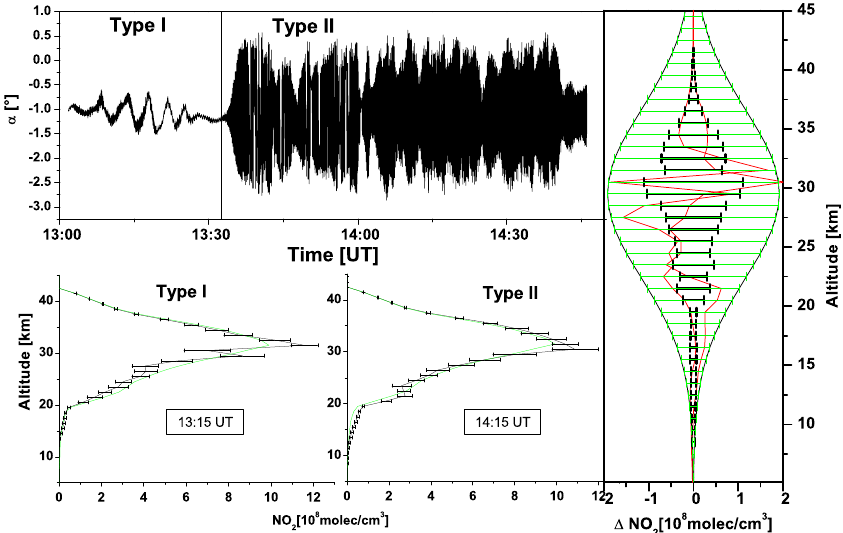
Fig. 6. Upper left panel: Extreme case (type I around 13:15 UTC and type II around 14:15 UTC) of pitch angle oscillation of the MIPAS-B gondola, as recorded by the attitude control system. Lower left panel: Concentration of NO 2 retrieved from Δ SCDs expected on a calm flight (green) and on a gondola undergoing type I oscillation (black). Lower middle panel: Concentration of NO 2 retrieved from Δ SCDs expected on a calm flight (green) and on a gondola undergoing type II oscillation (black). Right panel: Differences of retrieved and true profiles for both oscillation types (red), envelope of the differences defined as an upper limit for S osci (green error bars) and noise error S noise (black error bars) for comparison. oscillations are caused by wind shear acting on the balloon or by insufficient damping of the gondola 14